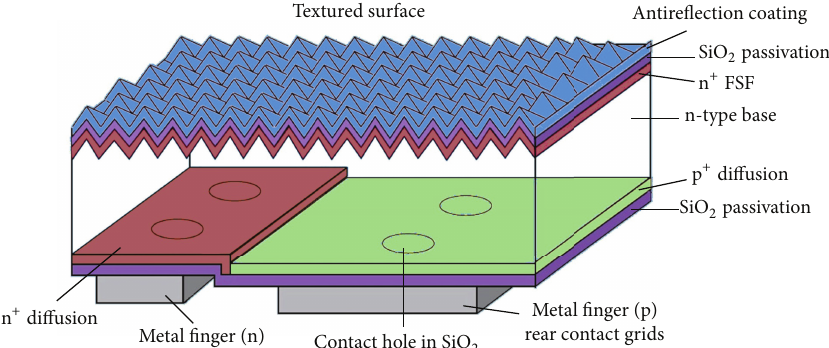
Figure 9: Schematic sketch of the IBC solar cell from SunPower [60].